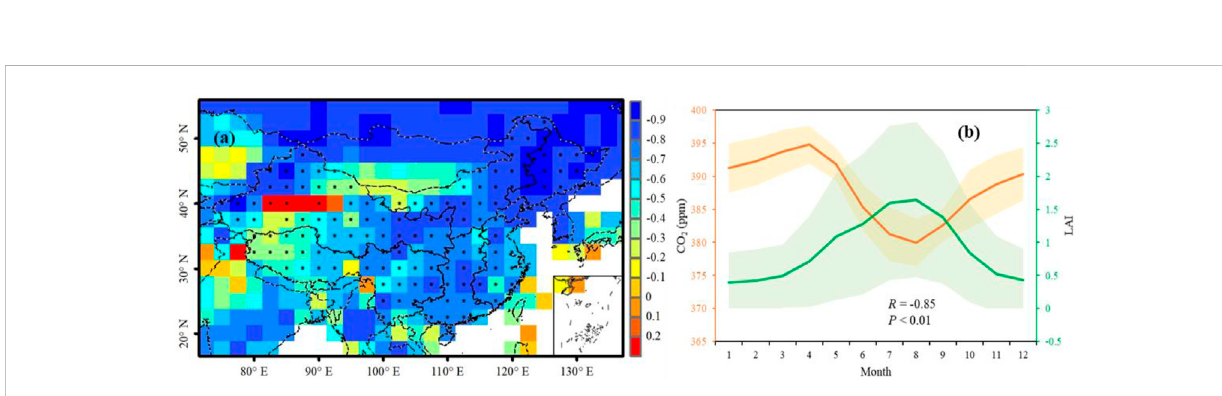
FIGURE 12 CorrelationanalysisbetweenCO 2 andLAIonthegrid (A) andnationalscale (B) atnearsurface.Itistobenotedthatthegridcells fi lledwithblackdots indicate that the correlation is signi fi cant at the 95%